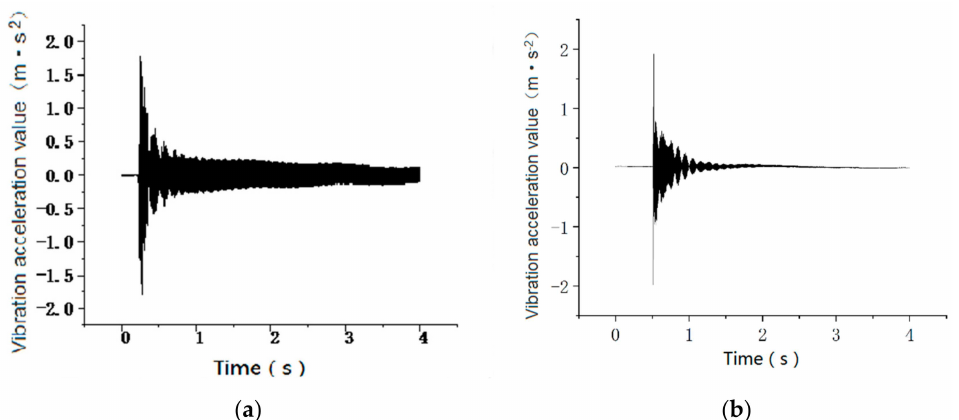
Figure 13. Axial vibration acceleration before and after vibration reduction optimisation. ( a ) Axial vibration acceleration before optimisation; ( b ) axial vibration acceleration after